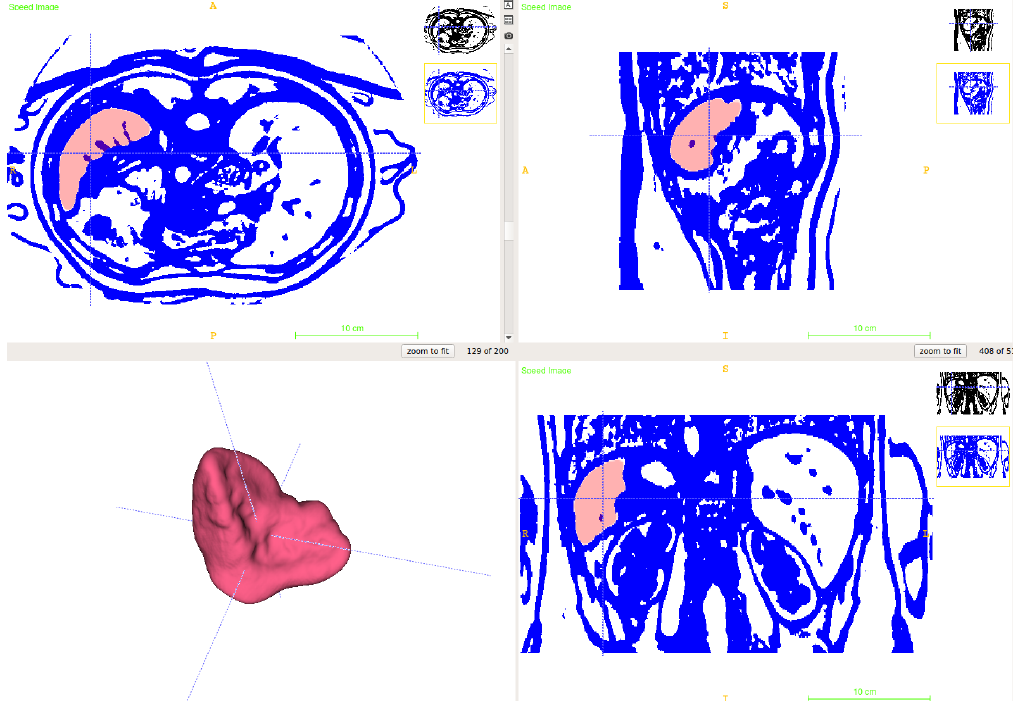
Figure 5. Results of spleen segmentation: α = 0.2, β =